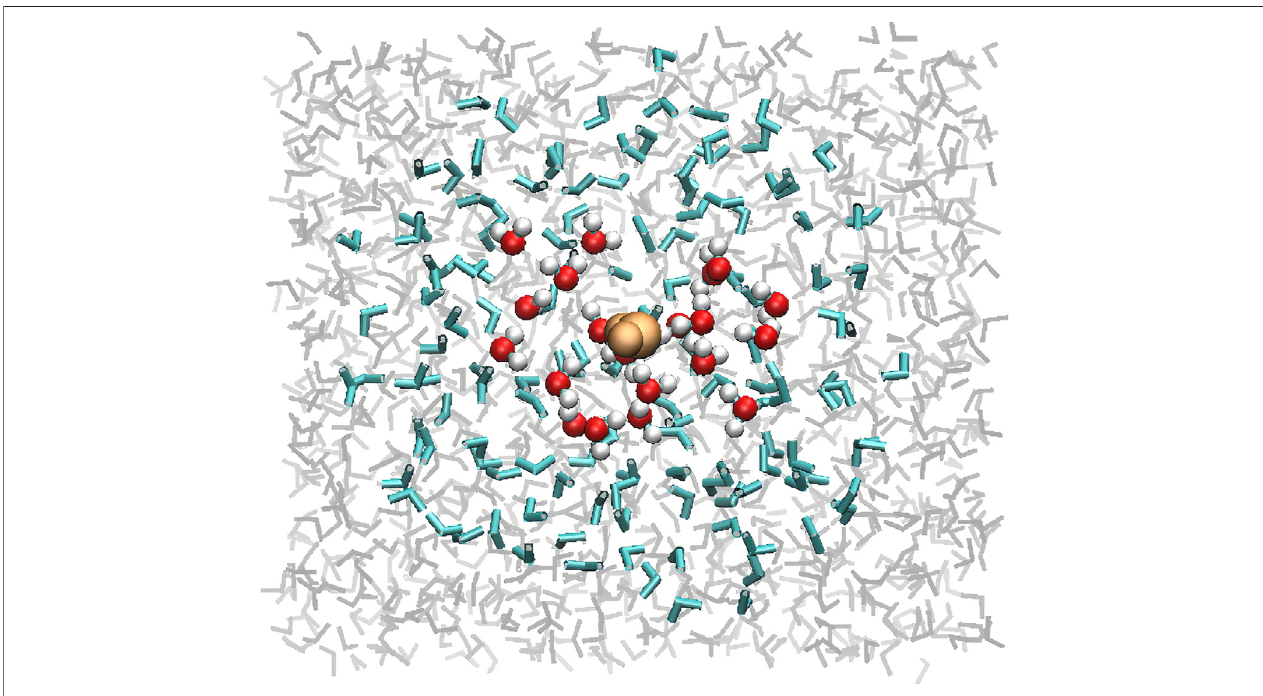
FIGURE 1 | Top view of a snapshot of amorphous ice issued from a MD trajectory at 77 K. The layers for the ONIOM calculation are represented accordingly: adsorbed H 2 O (beige), QMHigh (red/white), QMLow (blue), and the remaining water molecules (grey).